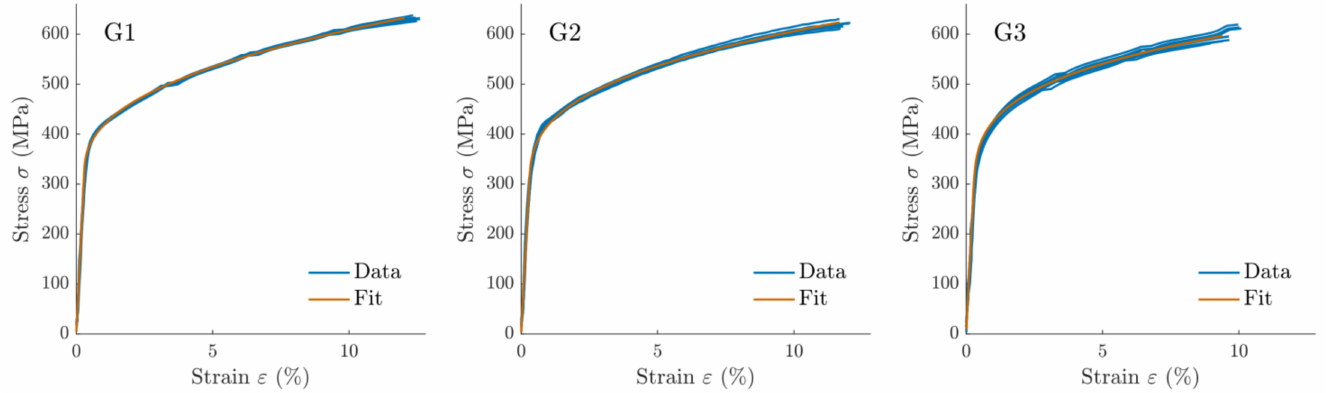
Figure 4. Comparison of experimental data and model fit for strain–stress curves of tensile tests limited to elastic and uniform hardening regions for G1, G2, G3 groups.